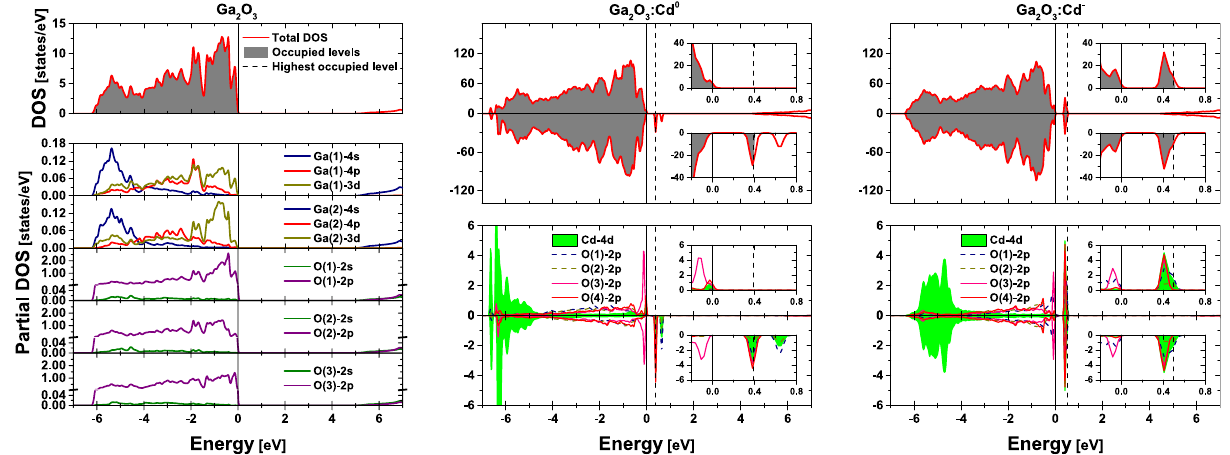
Figure 2. Total and atom-resolved partial density of states (DOS) of Ga 2 O 3 and supercells of ( Ga 2 O 3 :Cd) 0 and ( Ga 2 O 3 :Cd) − . The top valence band of Ga 2 O 3 is set at 0 eV (full line) and the energy of the highest occupied level is represented by a dashed line. For pure Ga 2 O 3 , both lines are coincident. The insets show a zoomed energy range focused on the impurity band. Partial DOS includes orbital contribution from all non-equivalent atoms of Ga 2 O 3 , as well as the 4 d contribution of Cd and the 2 p contribution of its neighboring O atoms (due to symmetry break, Cd has 4 non-equivalent O neighbors instead of 3).